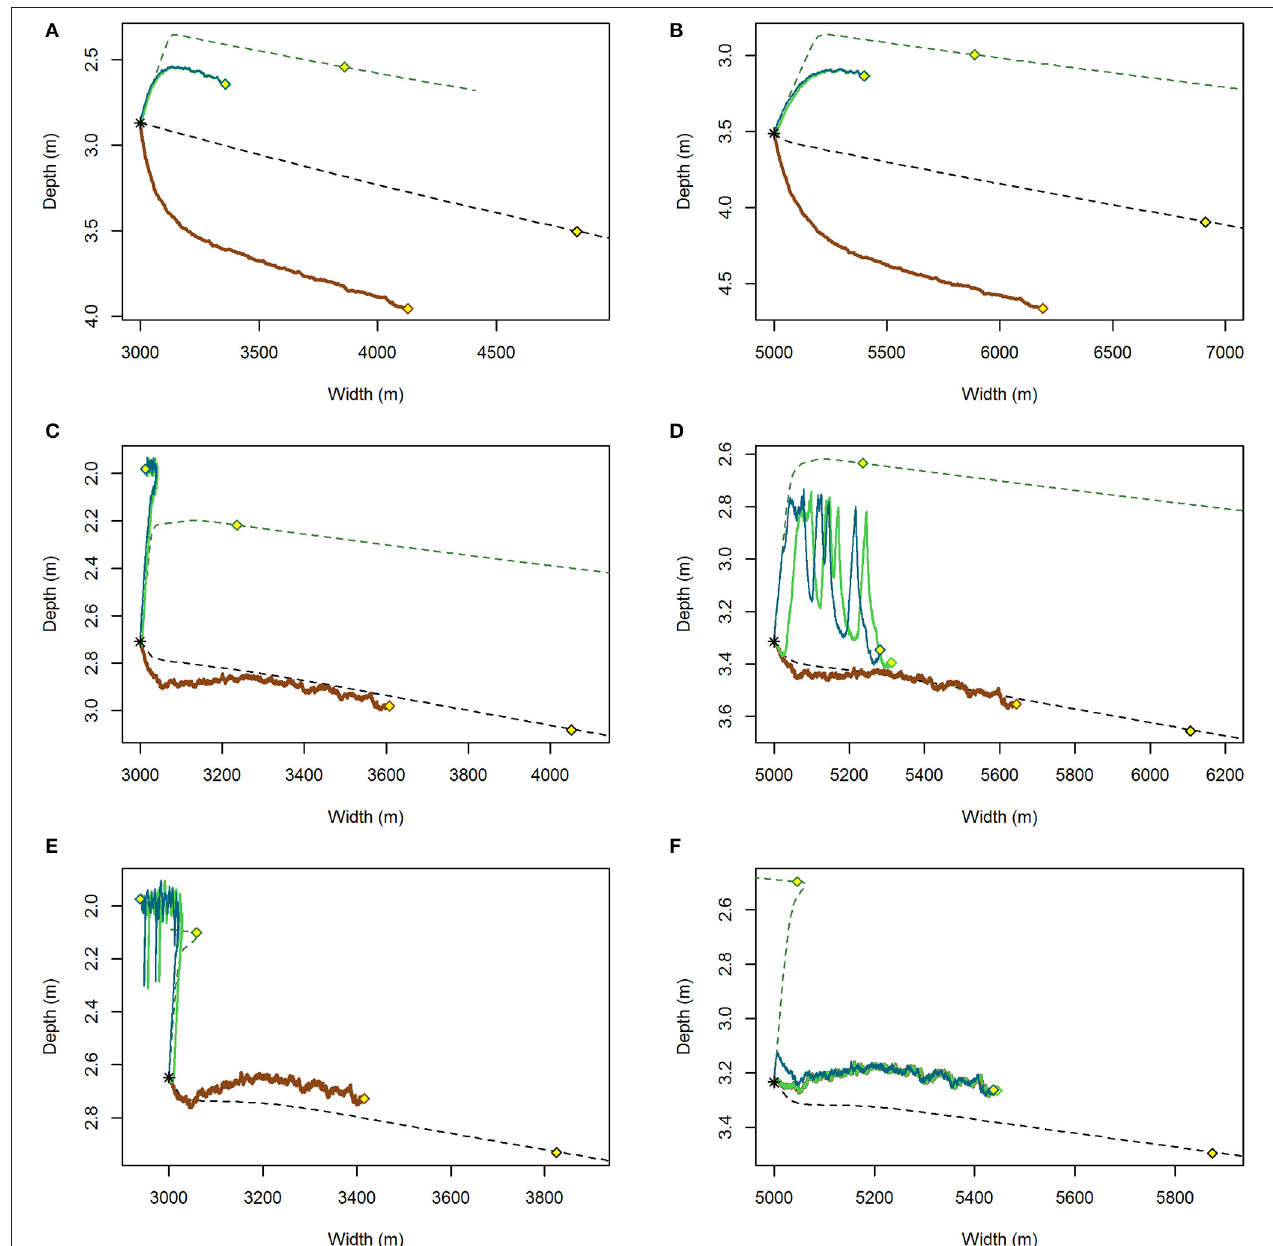
FIGURE 6 | Variable (solid) and constant wind (dashed) trajectories of tidal flat depth and width for the coupled system initiated at a tidal flat width of 3,000m (A,C,E) and 5,000m (B,D,F) for RSLR = 4mm year − 1 and (A,B) Co = 10 mg/L, (C,D) Co = 30 mg/L, (E,F) Co = 40 mg/L. The smooth dashed lines represent trajectories under a constant wind U 85 = 8.5m s − 1 for a system without seagrass (black line) and with seagrass (green line). Superimposed are trajectories under variable wind without seagrass (brown), with the possibility of seagrass to establish from 1 shoot m − 2 (green), and 500 shoots m − 2 (blue). Points (yellow) along each line represent the state of the system after 500